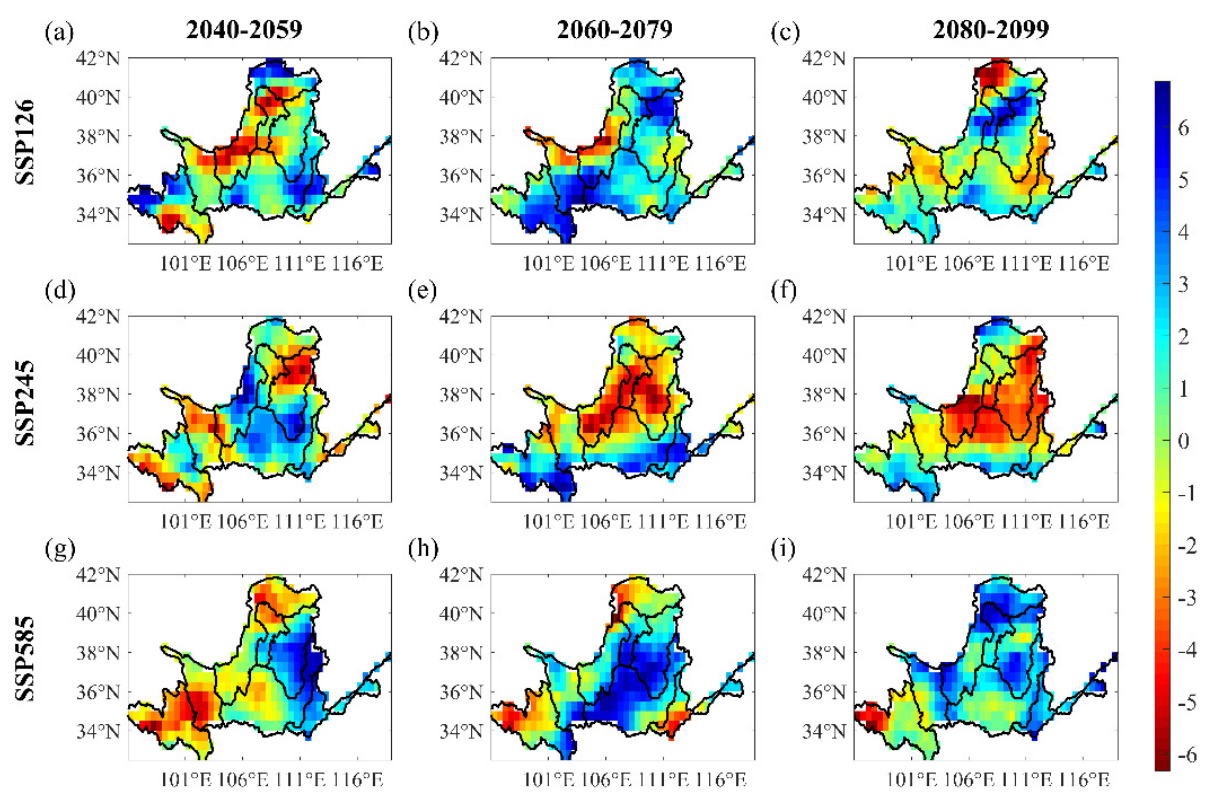
Figure 8. Spatial distribution of drought tendency from SSP126, SSP245, and SSP585 over 2040–2099 in the Yellow River basin. ( a – c ) are the drought tendency of near future, middle future, far future under SSP126, ( d – f ) are the drought tendency of near future, middle future, far future under SSP245, ( g – i ) are the drought tendency of near future, middle future, far future under SSP585.